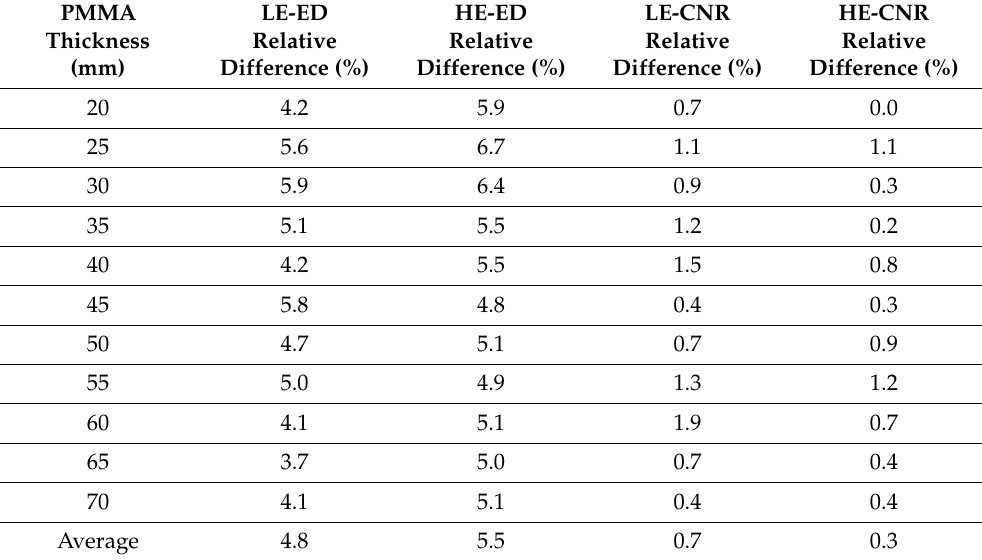
Table 3. Relative difference (absolute difference divided by mean value) between the two centers of ED and contrast-to-noise ratio (CNR) from LE- and HE-images obtained by acquiring CEM images of the PMMA phantom at increasing thickness in the automatic exposure (AEC) mode.